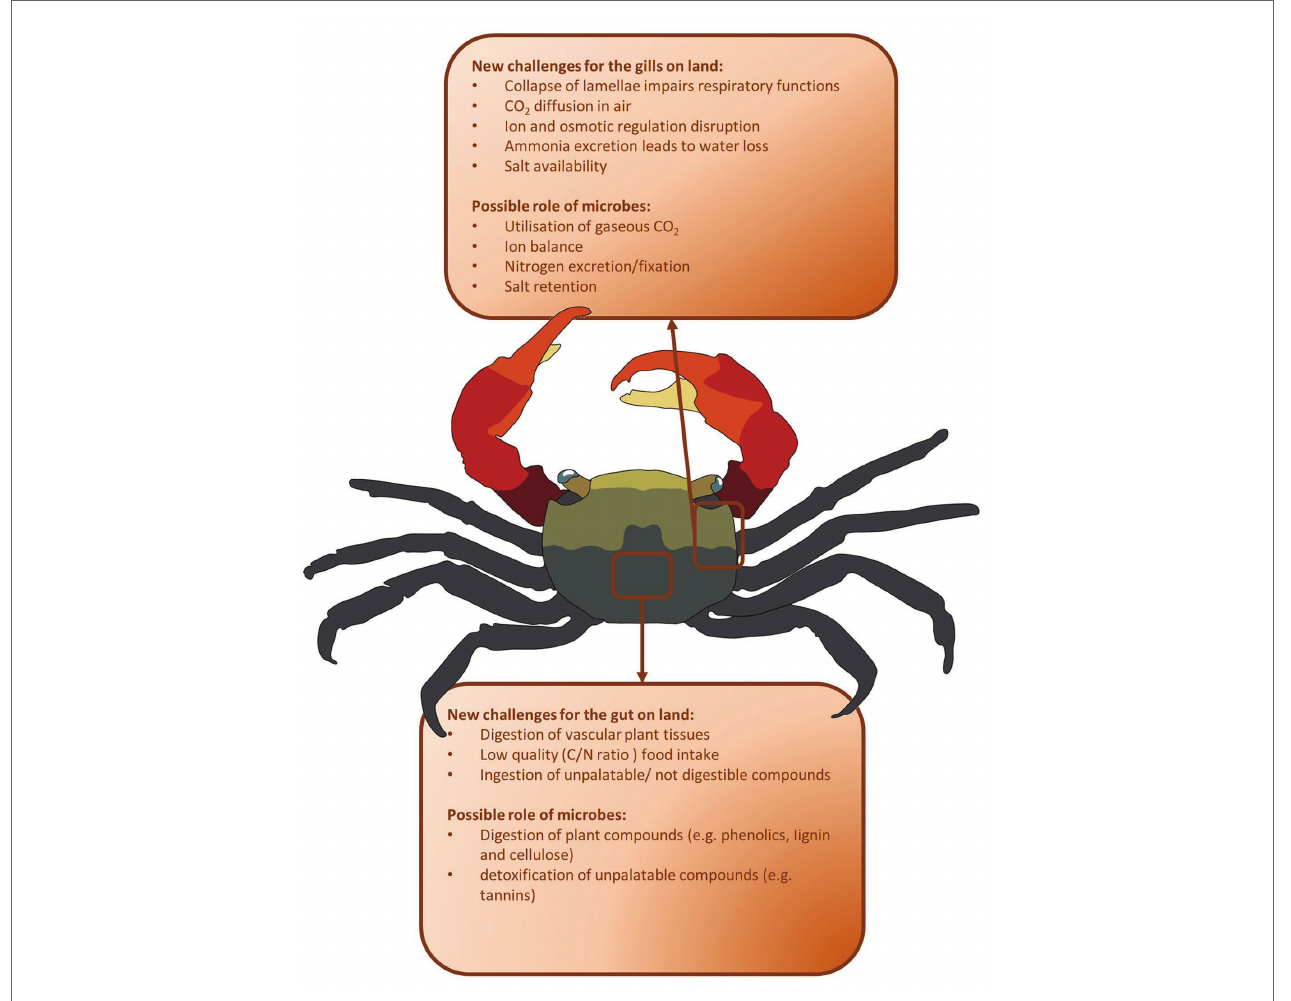
FIGURE 2 | Main challenges met during terrestrialization and possible microbial contribution. Respiratory/urinary and digestive systems are predicted to be the mostly impacted by water-to-land transition. Microbes may help to improve gut functionality toward new nutrient sources (e.g., vascular plant material) and gills functionality in relation to excretion of nitrogen toxic